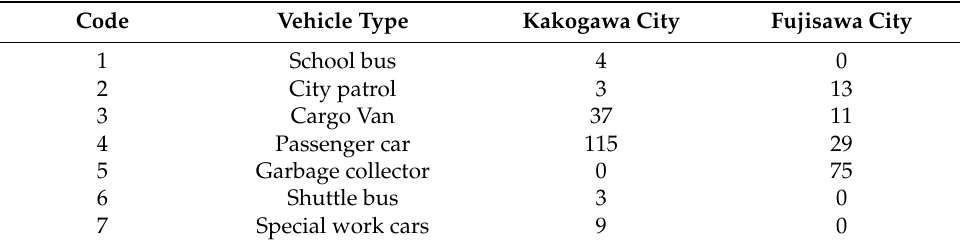
Table 2. Number of public vehicles equipped with global positioning system (GPS) devices. Code